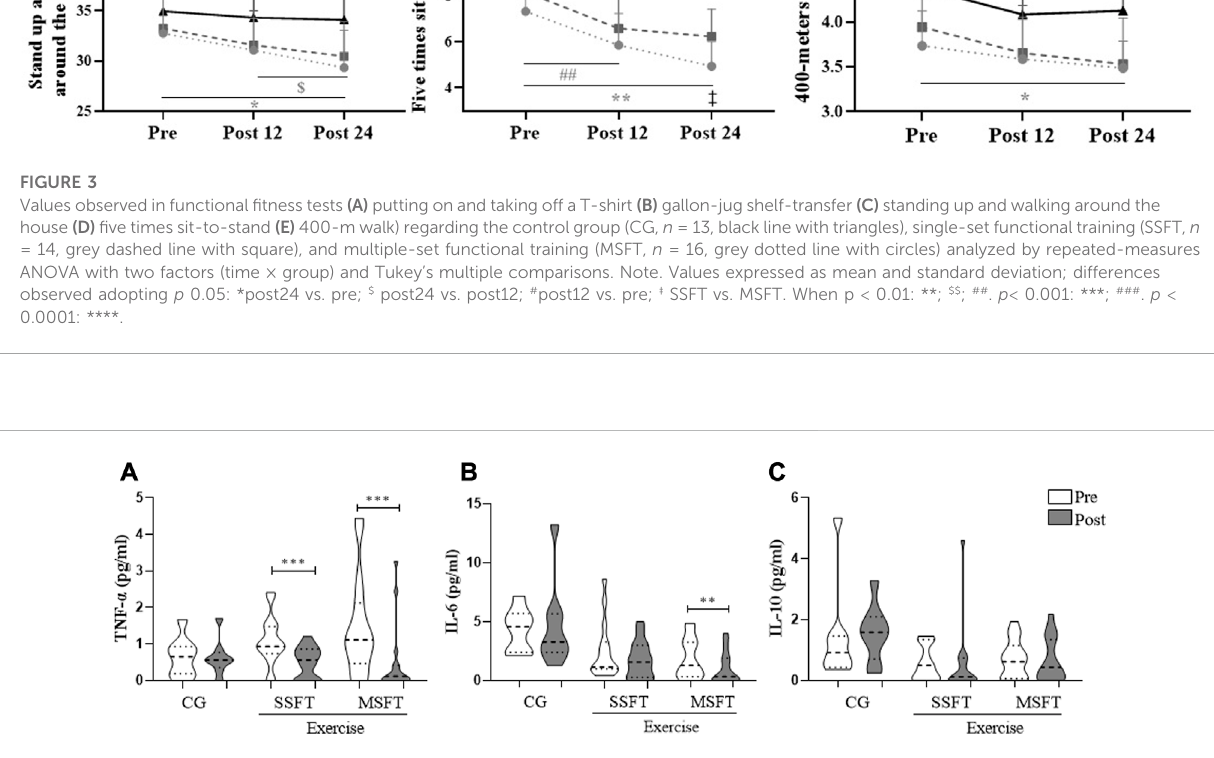
FIGURE 4 Plasma concentration of cytokines (A) TNF- α (B) IL-6 (C) IL-10 collected pre and post – 24 weeks of Single – set functional training (SSFT), Multiple – set functional training (MSFT), or Control (CG). * p < 0.05 in comparison to the pre – test. Within – group comparisons (pre vs. post) based on Wilcoxon signed – rank test. Between – groups (i.e., CG, SSFT, and MSFT) comparisons based on the Kruskal – Wallis test. When p < 0.01: **; p value < 0.001: